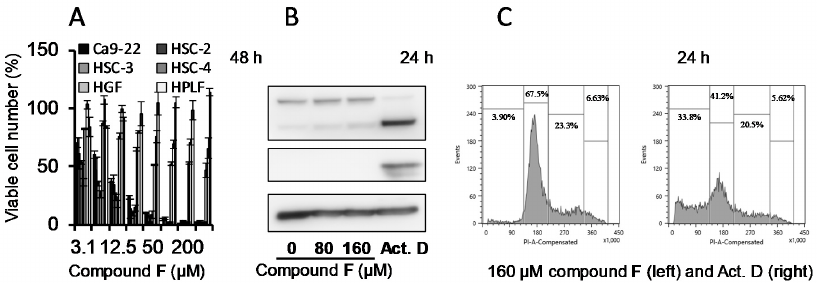
Figure 5. 7-Methoxy-2-(4-morpholinyl)-4 H -1-benzopyran-4-one (Compound F, Figure 4F) showed higher cytotoxicity against human OSCC cell lines as compared with normal oral mesenchymal cells ( A ), without induction of caspase-3 activation ( B ) nor producing subG 1 cell population ( C ). Actinomycin (Act. D) (1 μ M) was used as positive control. Cited from Reference [35] with permission.